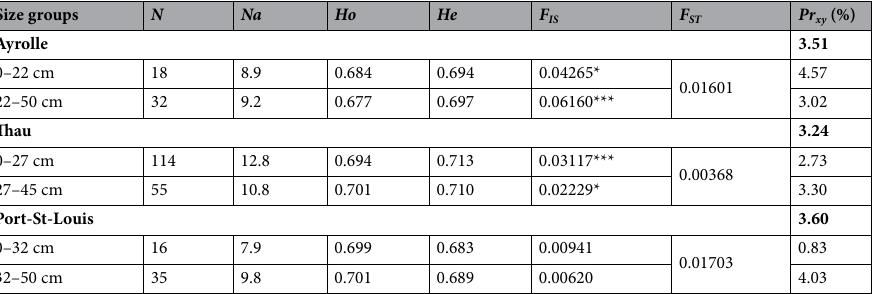
Table 4. Summary statistics for the two size classes in Ayrolle, Thau and Port-St-Louis. Significant values of F IS are indicated with *p-value < 0.05; **p-value < 0.01; ***p-value < 0.001. N the number of individuals in the size classes, Na the mean number of alleles, Ho the observed heterozygosity, He the expected heterozygosity, F IS the inbreeding coefficient, F ST values of pairwise comparisons between size classes and Pr xy the percentage of individuals sharing at least one common parent (i.e. percentage of relations with r xy > 0.25) within the two size groups and considering the two size groups mixed (in